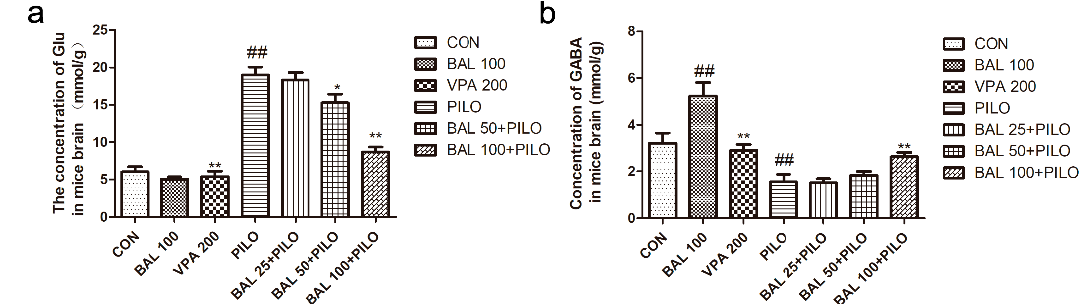
Figure 3. After the PILO injection for 72 h the concentration of GABA and glutamic acid in the brain. glutamic acid concentration( a ), GABA concentration( b ). Data are expressed as mean ± SEM ( n = 6), ## p < 0.05 (Student-Newman-Keuls) compared to CON group, * p < 0.05 (Student-Newman-Keuls) compared to PILO group and ** p < 0.01 (Student-Newman-Keuls) compared to the PILO group (One-way ANOVA and the Student-Newman-Keuls).